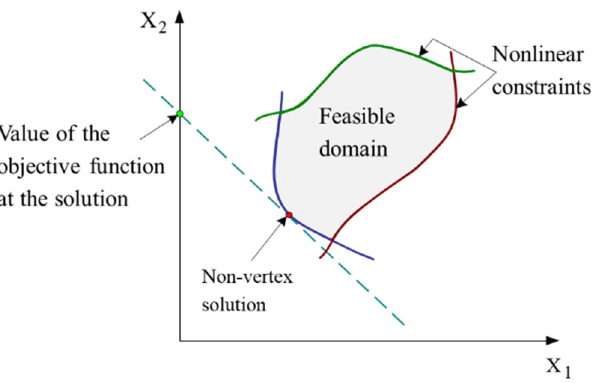
Figure 6. Representation of the vertex solution for the case of a linear programming involving the two variables X 1 and X 2 .